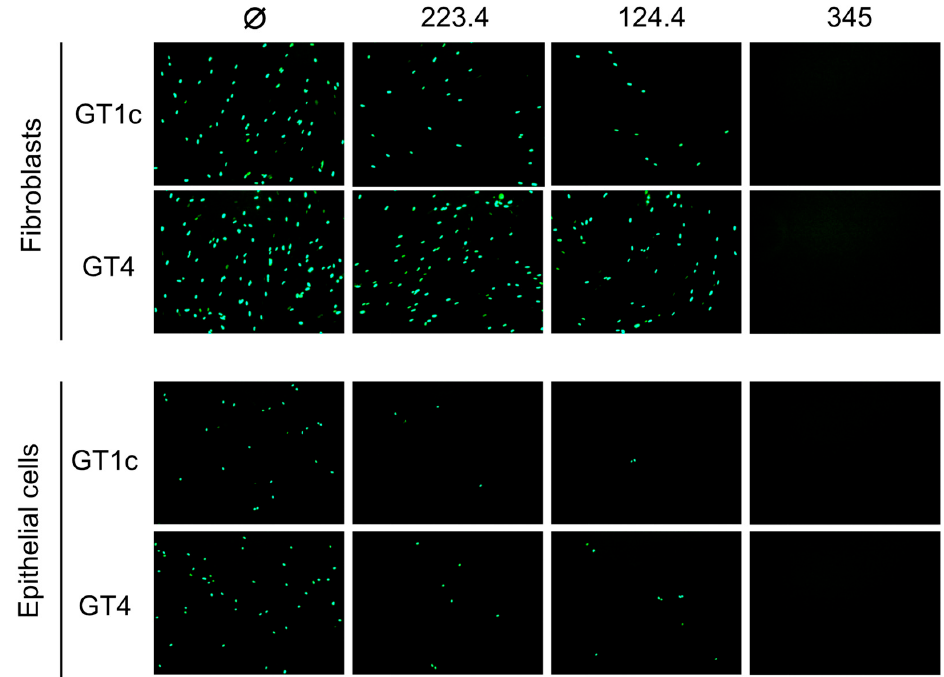
Figure 2. Strain Towne gO impairs the fibroblast entry neutralizing activities of mAbs targeting epitopes in gH/gL. Viruses GT1c (encoding TB40/E gO) and GT4 (encoding Towne gO) were incubated for 1 h at 37 °C in medium (Ø) or medium containing 100 µg/mL of mAbs 223.4, 124.4, or TRL345, then added to MRC-5 fibroblast or ARPE-19 epithelial cell monolayers in 96-well plates. Following incubation at 37 °C for 48 h, infected cells were detected by immunofluorescent staining for the CMV IE1/2 proteins. Representative images are shown.